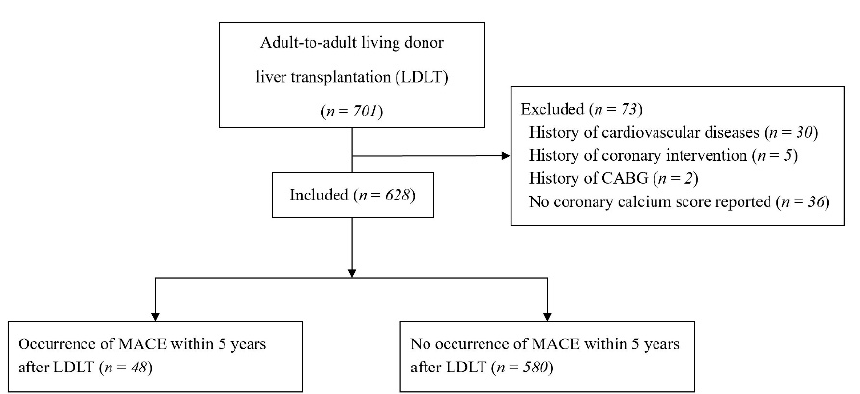
Figure 1. Diagram of the participant selection process. CABG, coronary artery bypass grafting; CTCA, computed tomographic coronary angiography; MACEs, major adverse cardiac